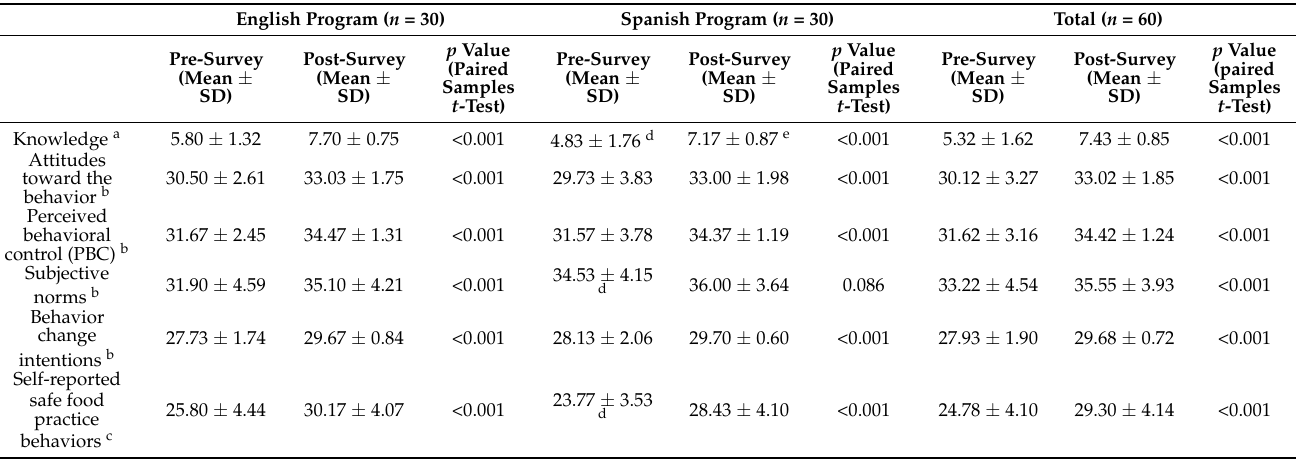
Table 3. Overall measurements of knowledge, theory of planned behavior (TPB) constructs, behavior change intentions, and self-reported safe food practice behavior before and after the